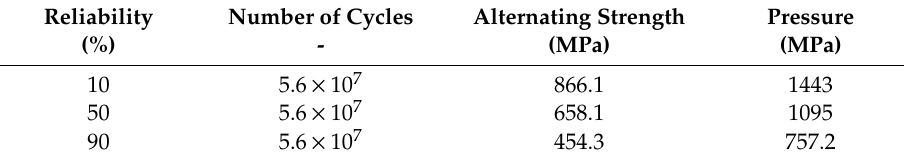
Table 3. The alternating strength and contact pressure for the designed number of cycles. Reliability